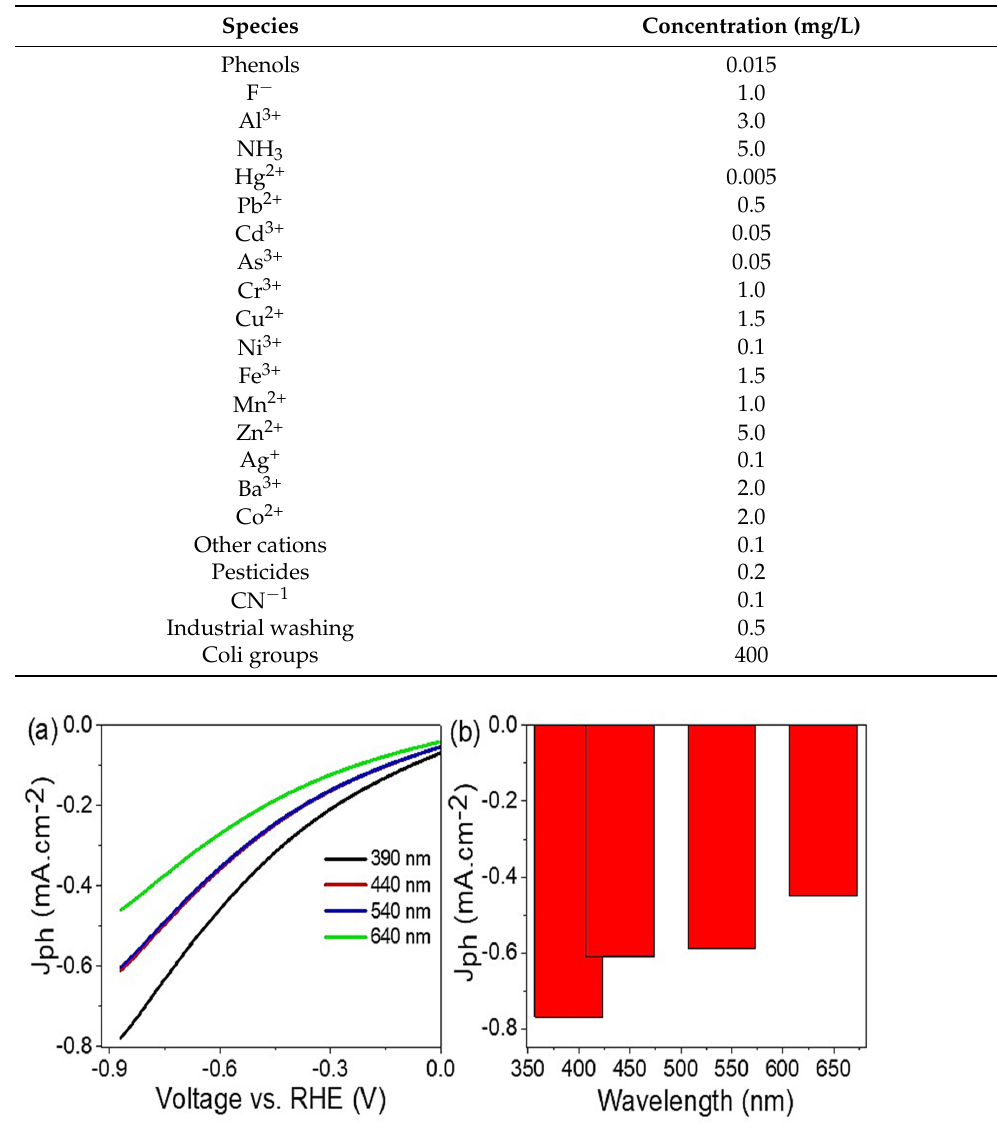
2 /CuO/Cu photoelec-